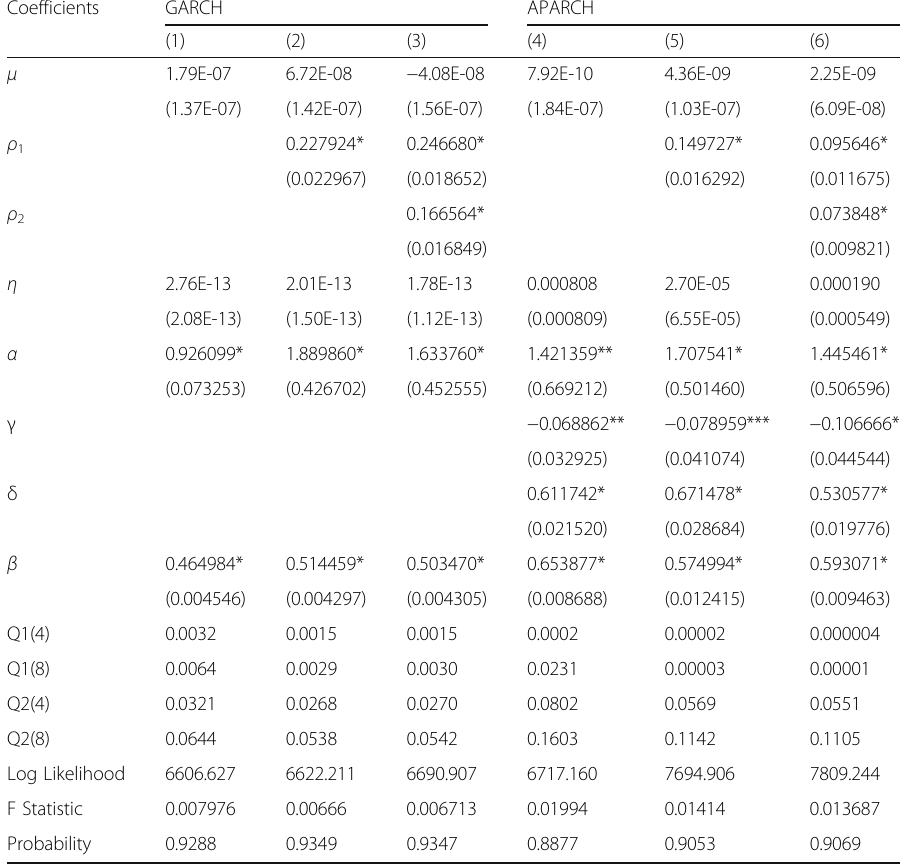
Table 3 Estimation results of GARCH and APARCH models with Student ’ s t -distribution Coefficients GARCH APARCH